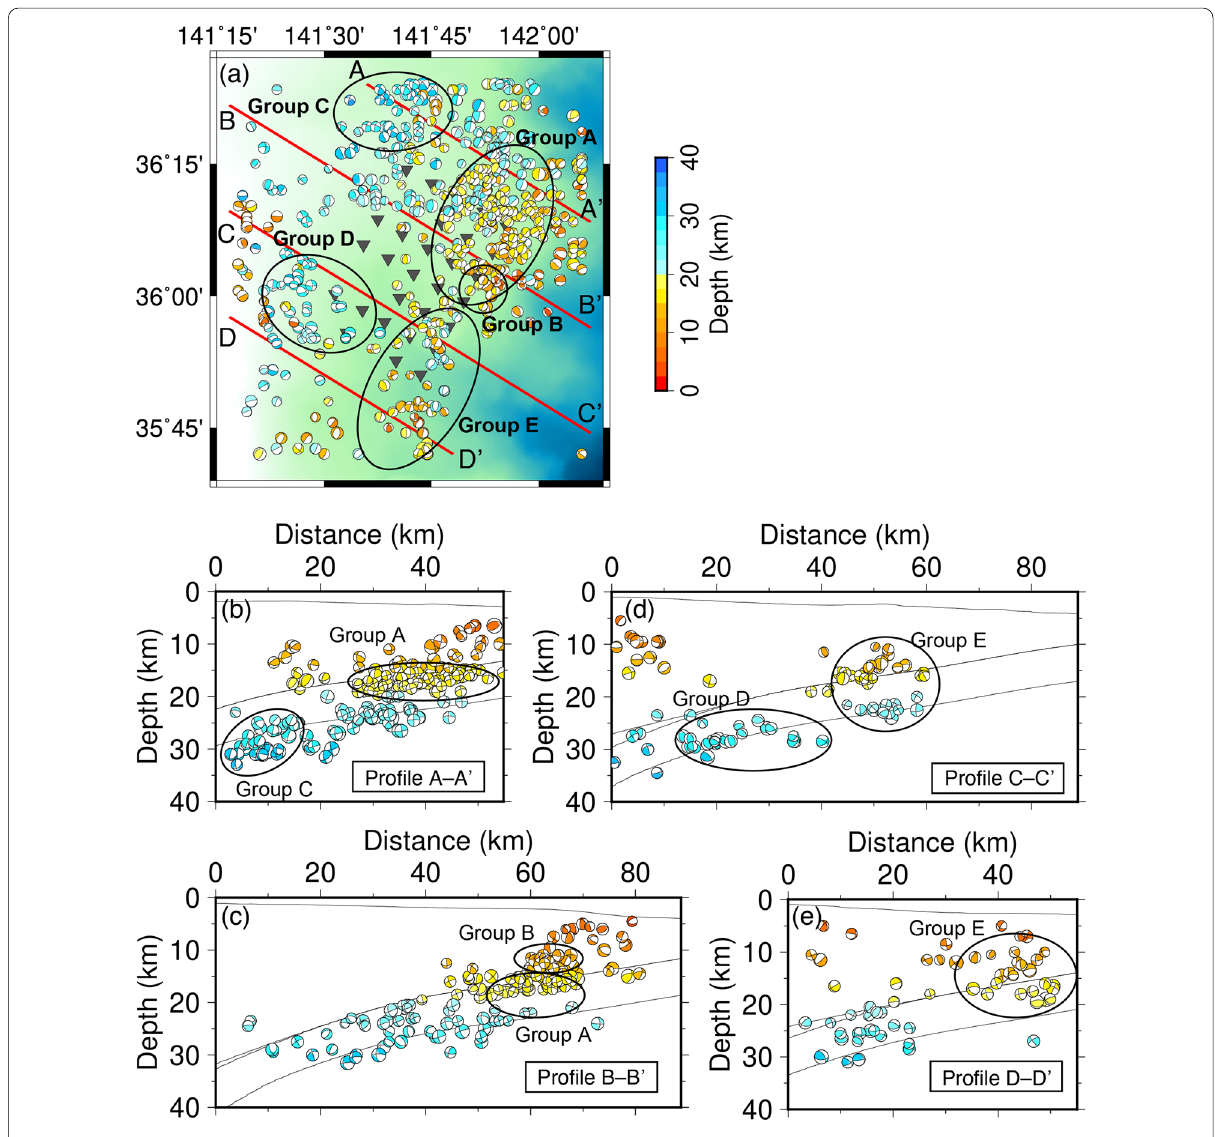
Fig. 6 a Spatial distribution of the obtained CMT solutions. The color of the focal mechanisms shows their depth. b – e Cross sections with the profiles of A–A’, B–B’, C–C’, and D–D’, respectively. The thin lines show the bathymetry, the upper surface and oceanic Moho of the Pacific Plate, and the upper surface of the Philippine Sea Plate (Koketsu et al.